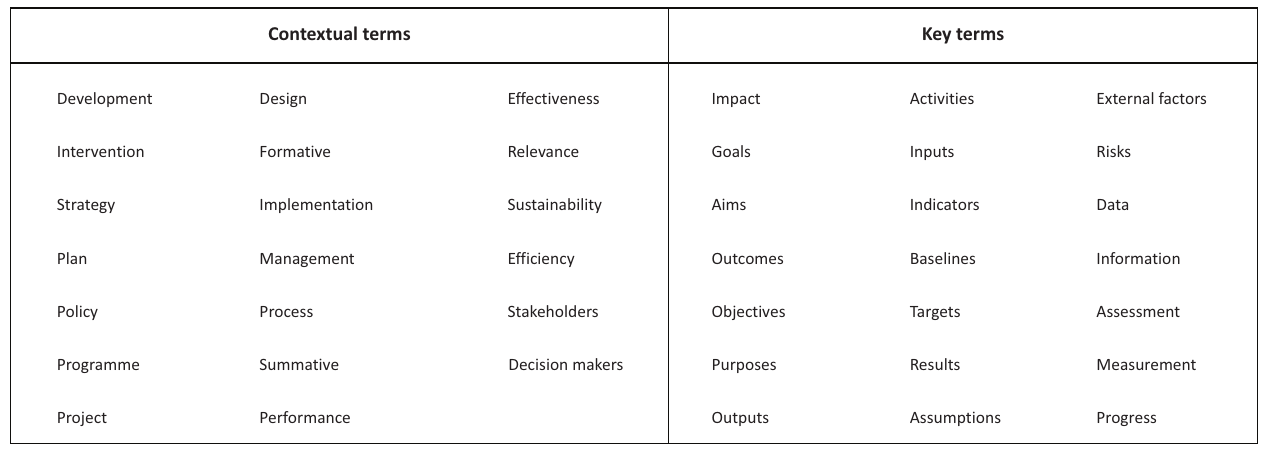
Figure 1: Showing contextual and key terms found in common definitions of monitoring and